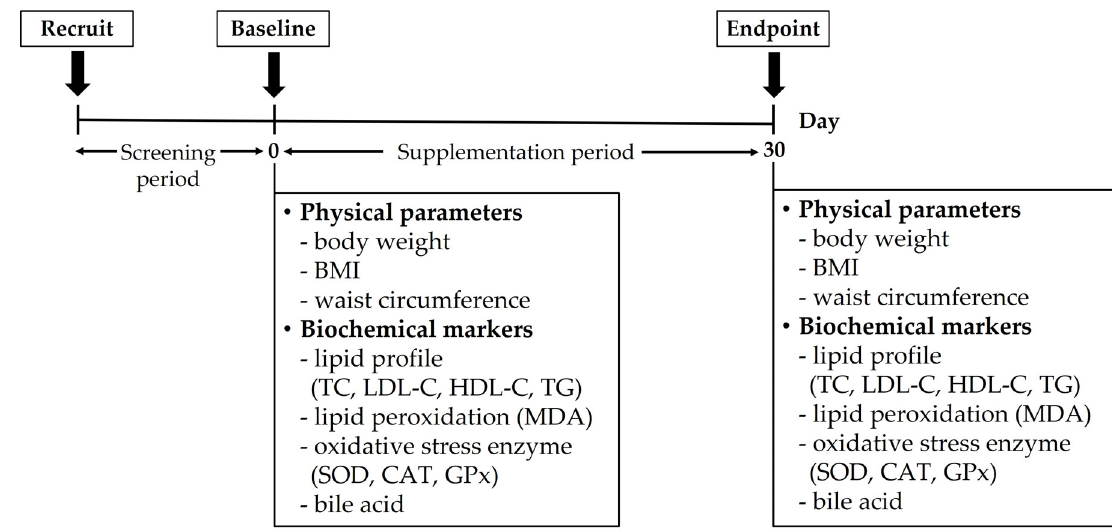
Figure 2. The study schedule of the clinical trial.